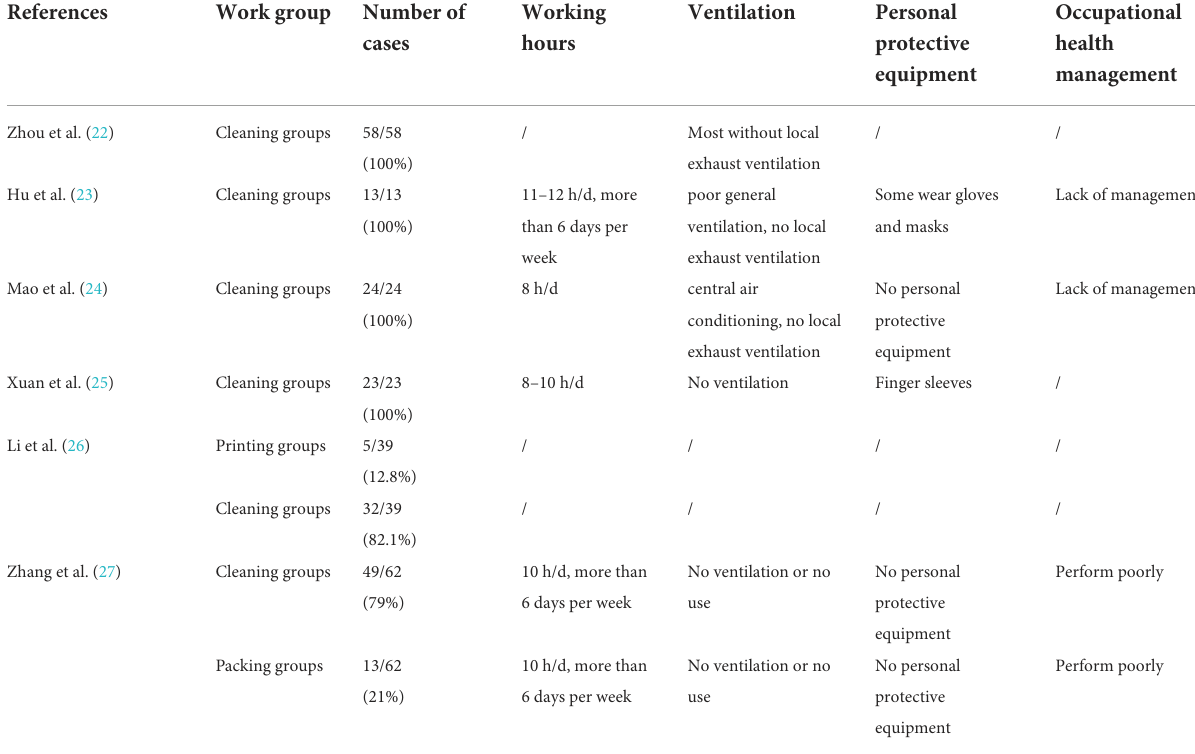
TABLE 7 Information on studies in China related to n-hexane occupational